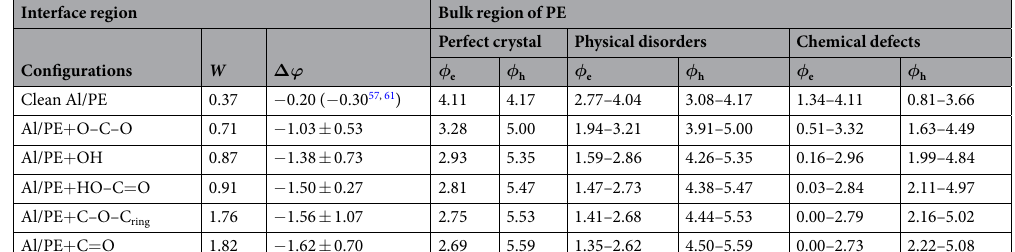
Table 3. Computed work of separation ( W , in J/m 2 ), vacuum level shift ( Δ ϕ , in eV) and electron and hole injection barriers ( φ e and φ h , in eV) of Al/PE interfaces (with and without imperfections). Experimental data, when available, is given in brackets.